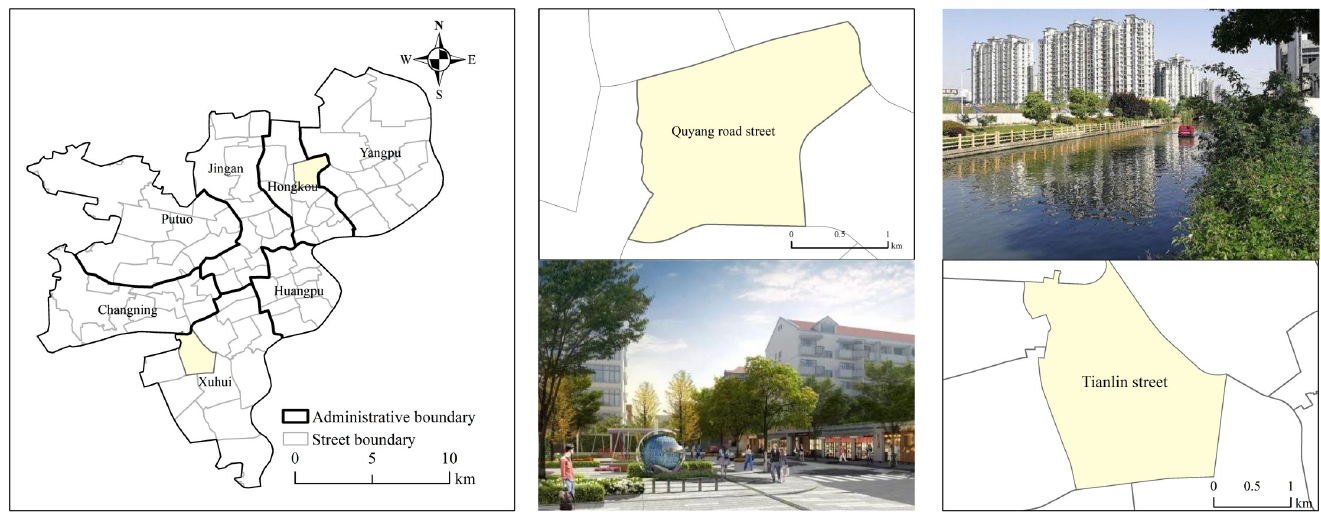
Fig 4. Description of the two cases. Tianlin Street and Quyang Road Street, including the location of the two cases and pictures of the scene. (Image Source: https://